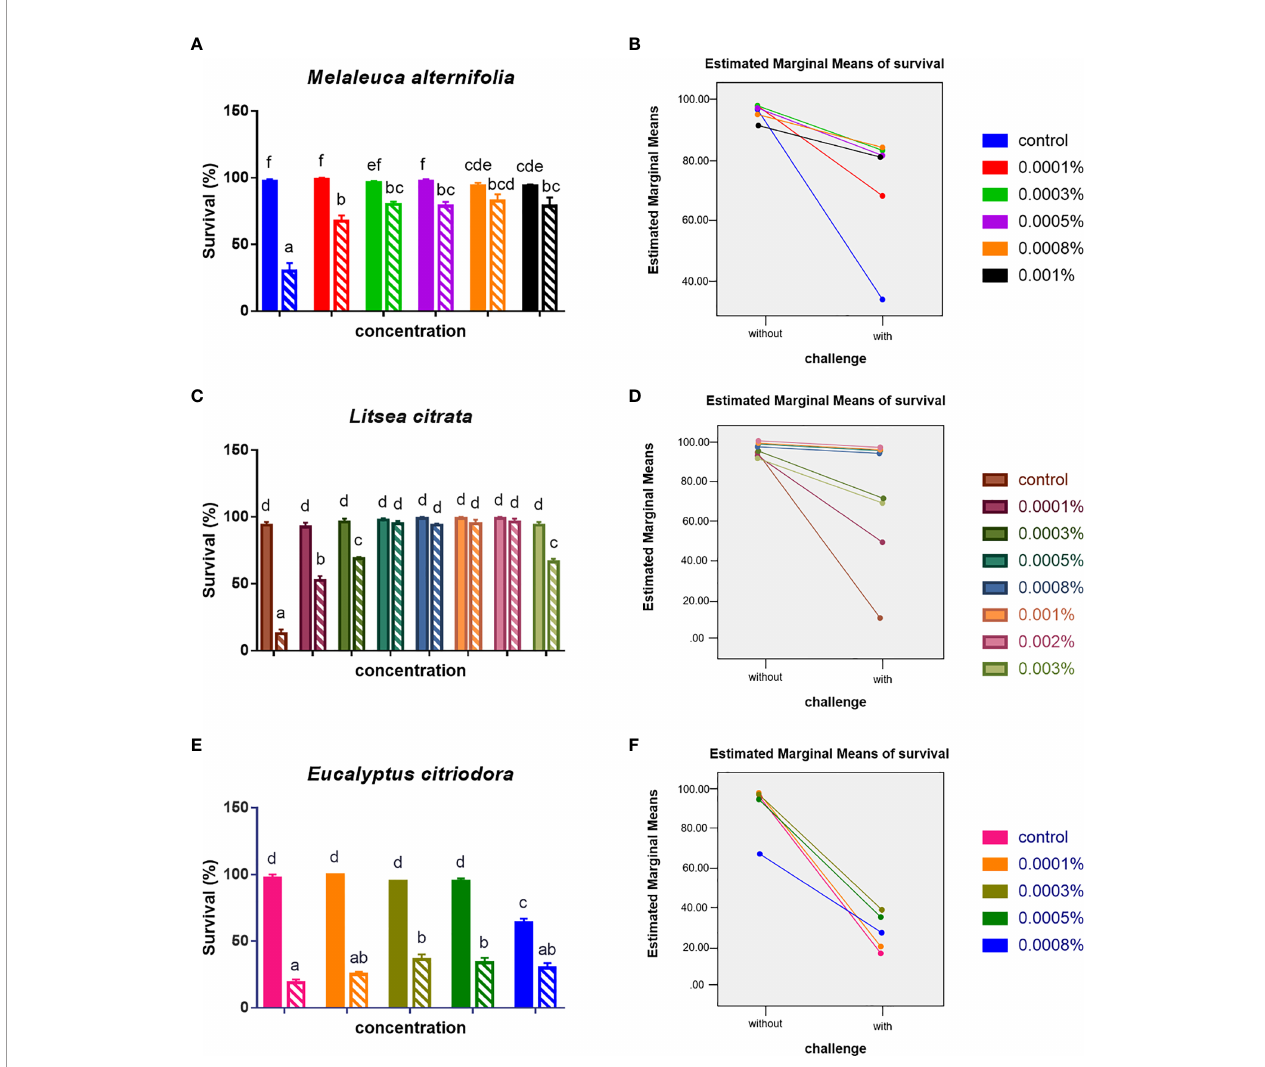
FIGURE 2 | Survival (mean ± SEM) of brine shrimp larvae 48 h after challenge with Vibrio campbellii BB120. (A) Treated with EO of Melaleuca alternifolia , (C) treated with EO of Litsea citrata , and (E) treated with EO of Eucalyptus citriodora . (B, D, F) showed the interaction plots between doses of each EO and with/without V. campbellii challenge, respectively, according to the output from two-way ANOVA. All treatments were carried out in four replicates. The bars without pattern were unchallenged groups; the opposite was challenged groups. Different letters indicated signi fi cant difference ( P < 0.05). Control: no EO added but consisted of 1% of